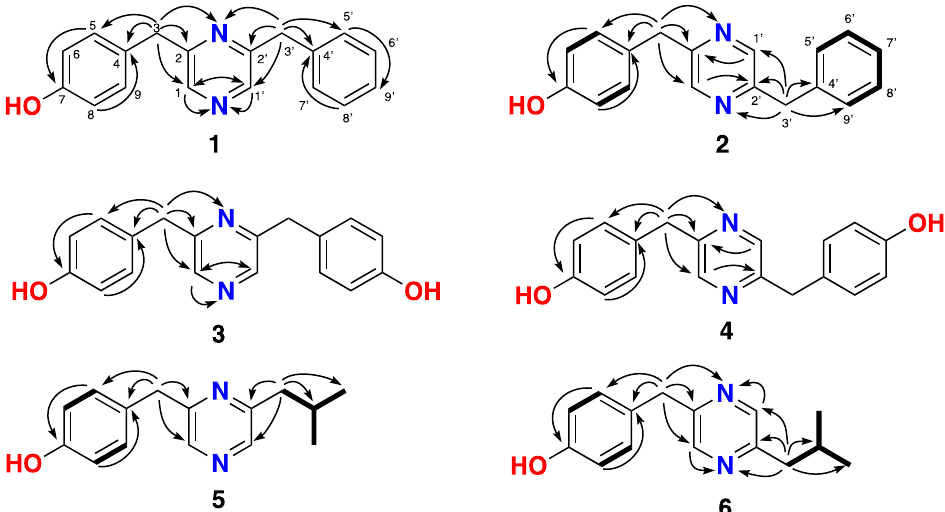
Figure 2. Key 1 H- 1 H COSY (bold lines) and HMBC ( 1 H- 13 C and 1 H- 15 N) NMR (nuclear magnetic resonance) correlations (arrows) observed for compounds 1 – 6 .